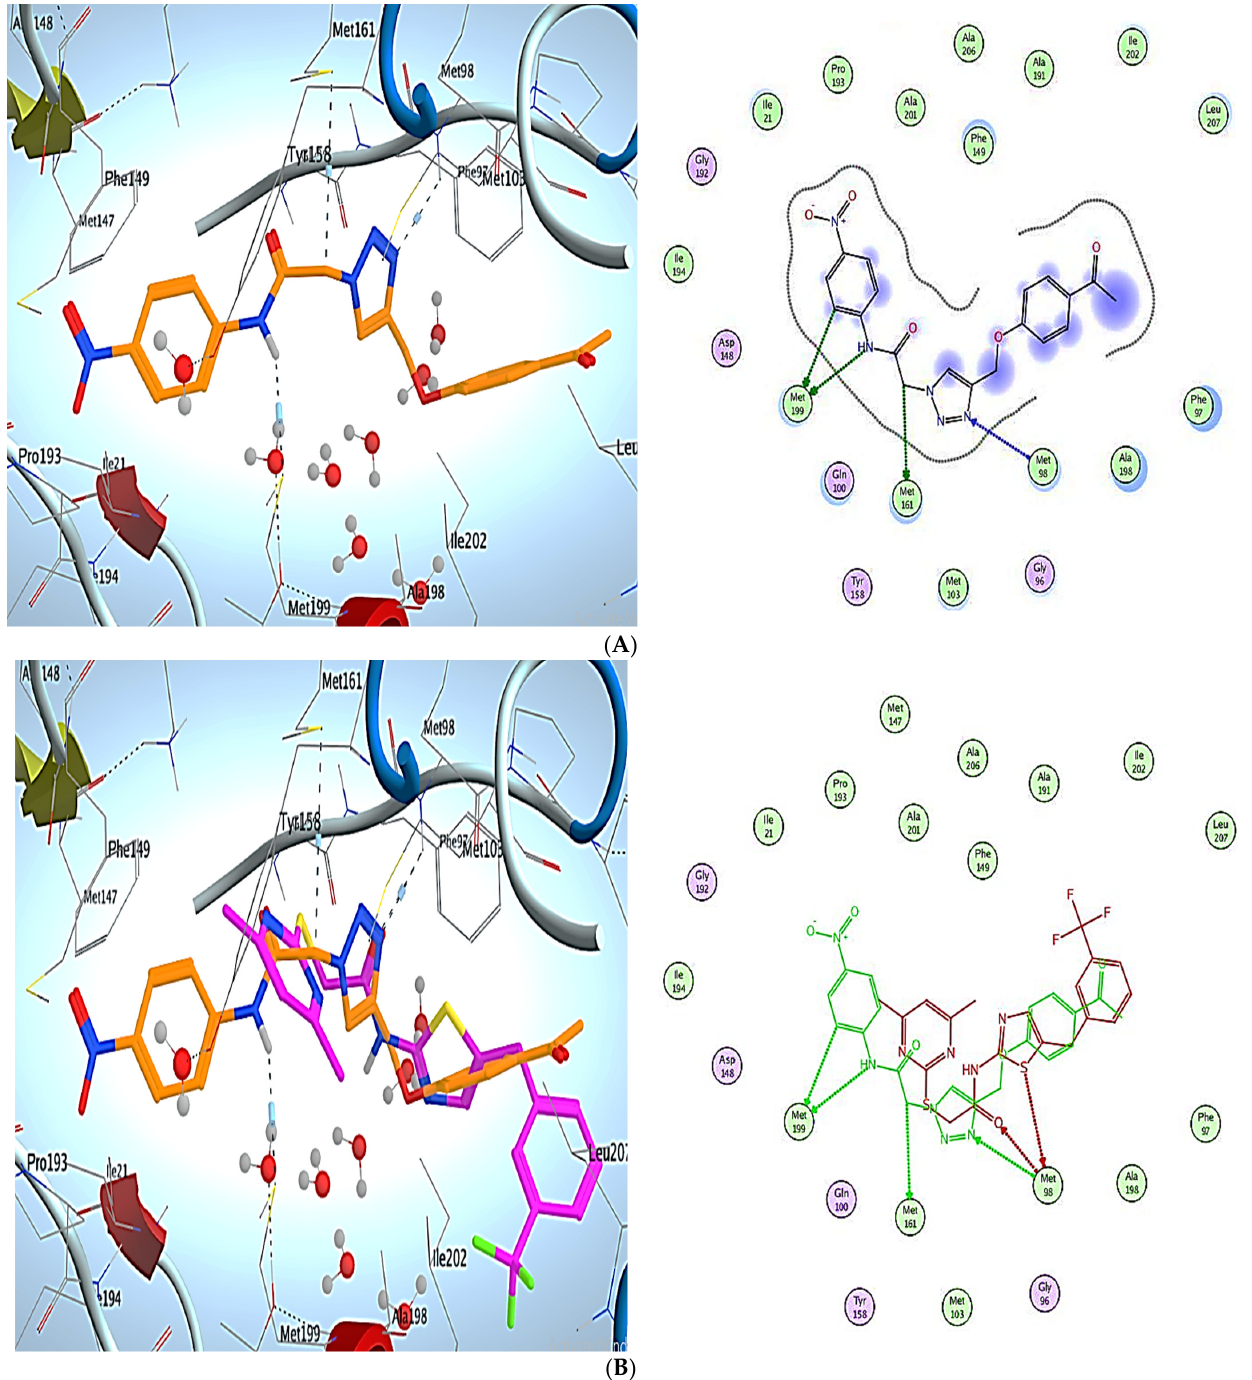
Figure 6. ( A ): Docking and binding pattern of compound 10 into InhA active site (PDB ID: 4UVD) in 2D (right panel) and 3D (left panel). ( B ): An overlay of the docked pose of compound 10 (brown) with the co-crystallized ligand (purple) into InhA active site in 2D (right panel) and 3D (left panel).